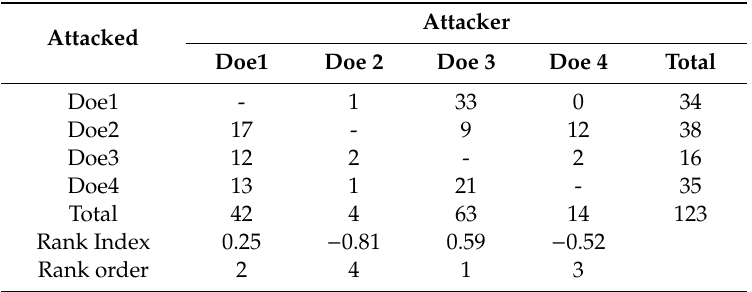
Table 4. Dominance rank order based on the number of fights among the does